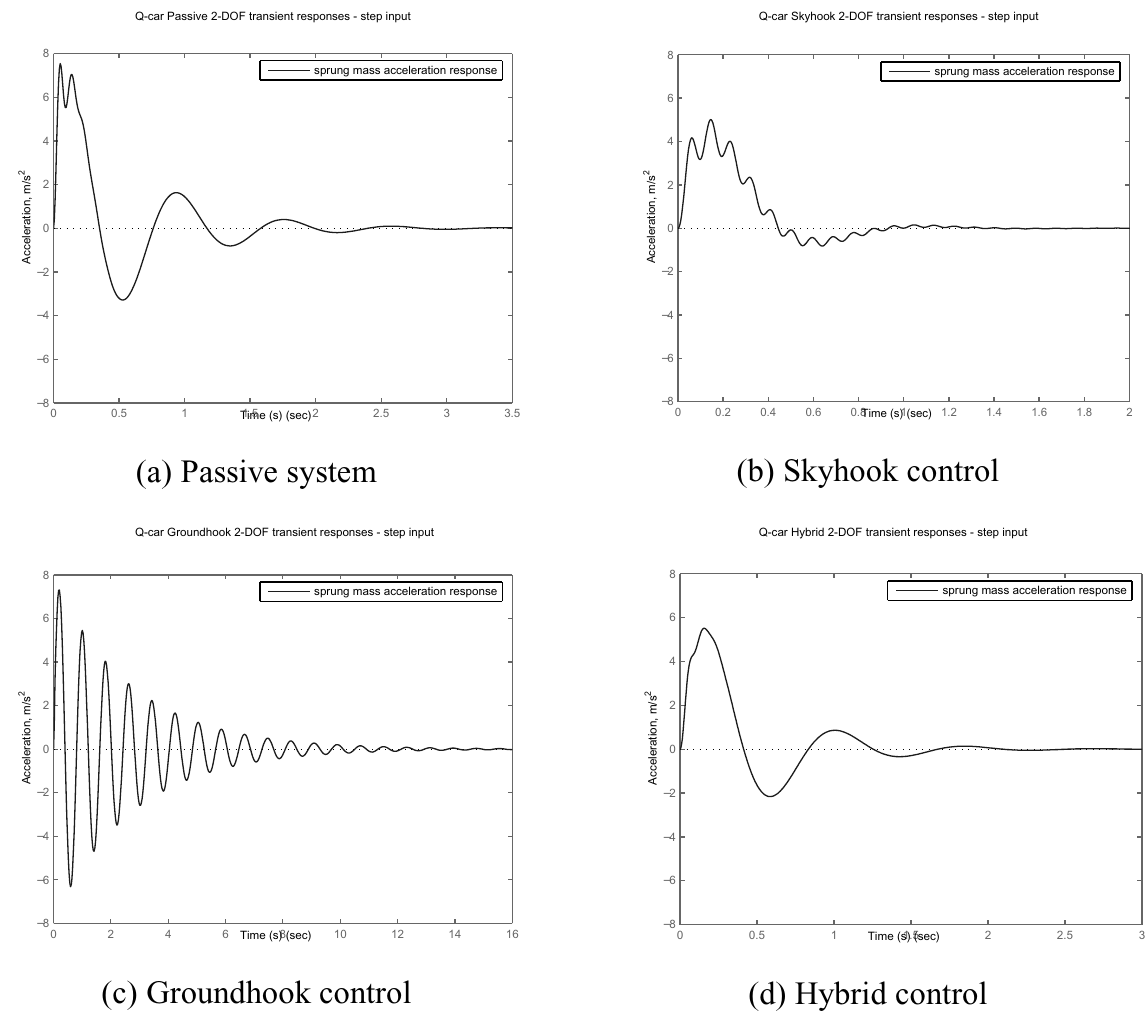
Fig. 2. Sprung mass acceleration